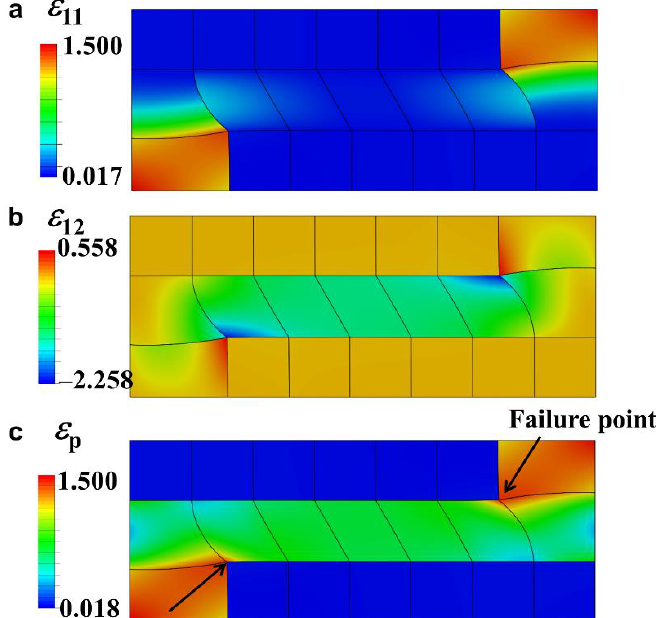
Figure 7. The distribution of ( a ) tension strain ε 11 , ( b ) shear strain ε 12 , and ( c ) maximum principal strain p of the optimal staggered structure at the moment of failure.